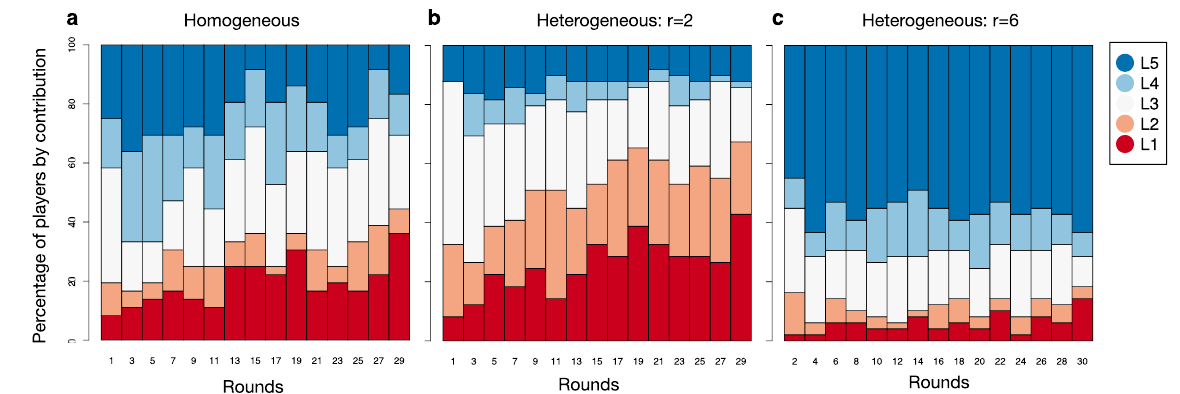
Figure 2. Percentage of players by contribution. The percentage of players in each class of contribution ( L 1 , L 2 , L 3 , L 4 , and L 5 , as defined in the main text) ( a ) in the homogeneous treatment at even rounds, ( b ) in the heterogeneous treatment with r = 2 and ( b ) in the heterogeneous treatment with r = 6. There are more players adopting the Nash solution of no contribution for r = 2 in the heterogenous treatment than in the homogeneous one for most rounds. In addition, fewer players contribute all the initial endowment if r = 2 in the heterogeneous treatment. Notice that for r = 6 in the heterogeneous treatment, there are many players deviating from the Nash solution of full